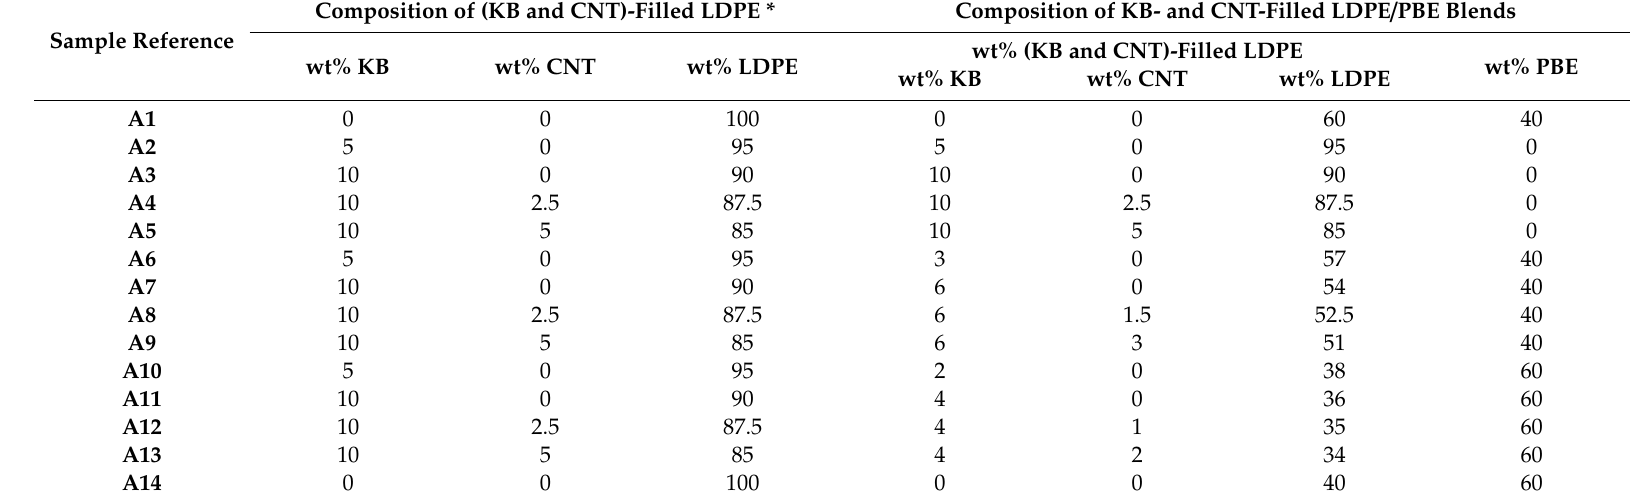
Table 1. Sample descriptions of the first design of experiment.